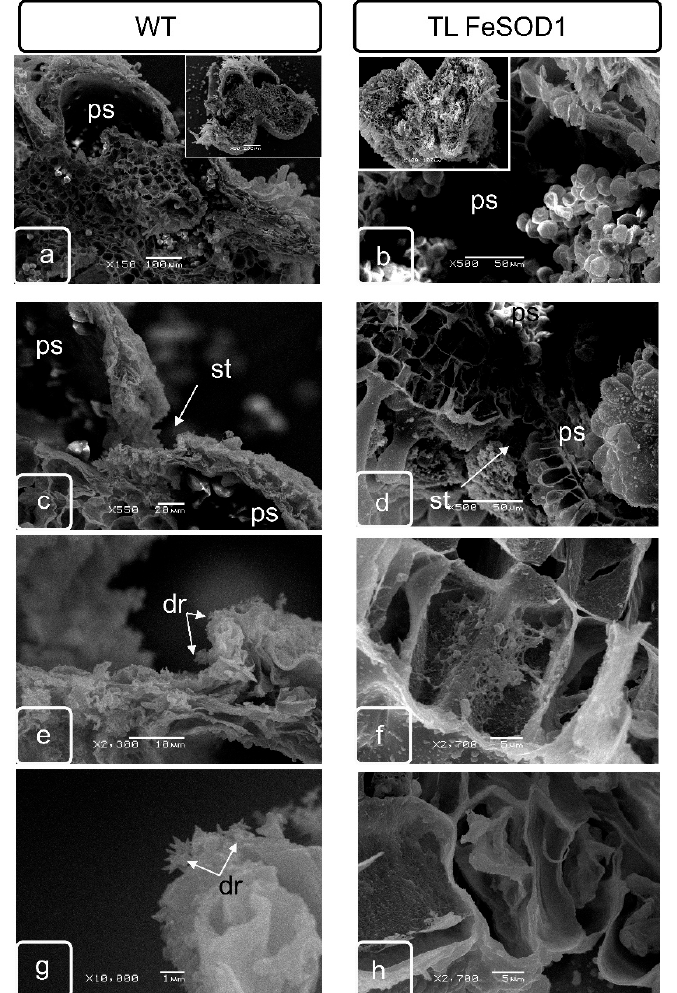
Figure 3. Scanning electron microscopy of cross sections at the top of anther. Pollen sac with pollen grains ( a , b ). General view of the cross section (inserts on ( a , b )) WT ( a , c , e , g ) and transgenic ( b , d , f , h